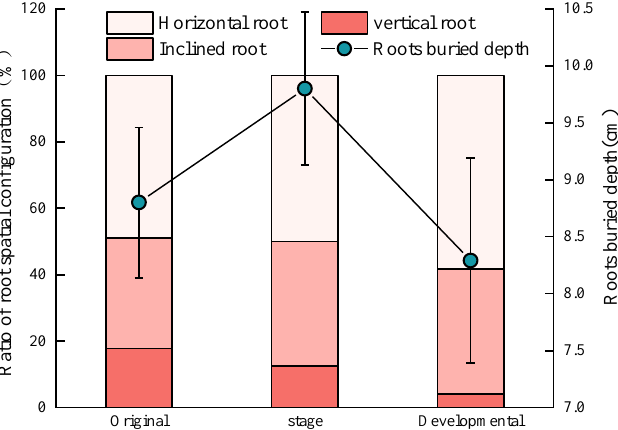
Figure 3. Spatial distribution characteristics of adventitious roots in N. tangutorum shrub.